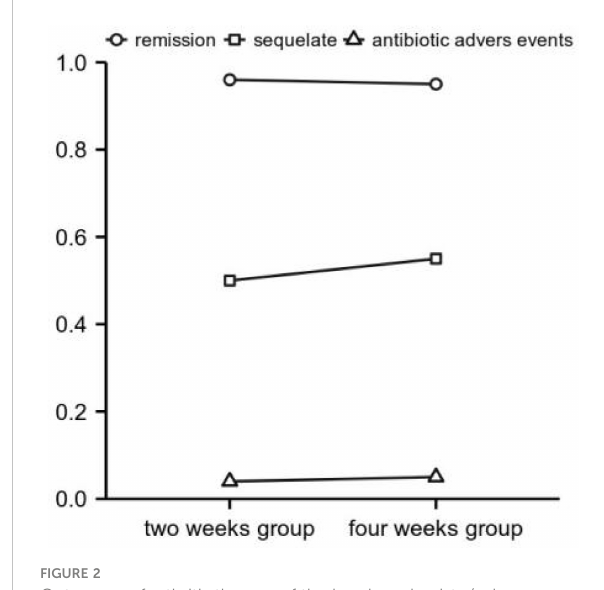
FIGURE 2 Outcomes of arthritis therapy of the hands and wrists (subgroup analysis). X-axis: study outcome parameters. Y-axis: number of corresponding episodes with proportions and absolute number of cases (Ross,